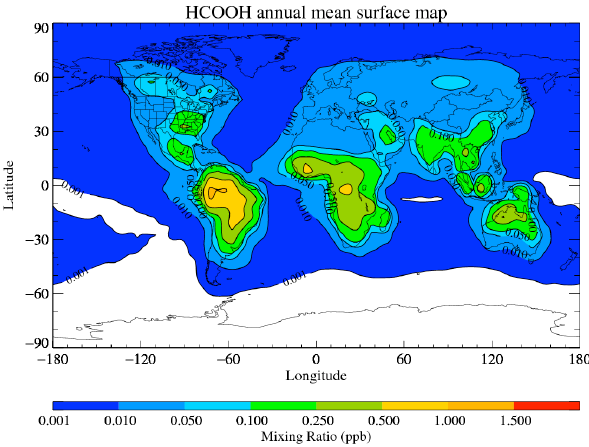
Fig. 8. The annual mean surface formic acid derived from the base case model